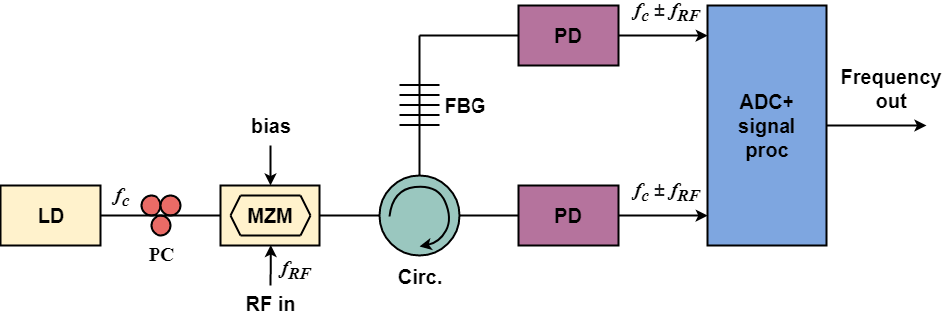
Figure 2. Schematic diagram of an IFM system based on a fiber Bragg grating for microwave frequency measurement. LD—Laser diode; MZM—Mach–Zehnder modulator; Circ.—Circulator; FBG—Fiber Bragg grating; PD—Photodiode (Adapted with permission from Ref [25]. Copyright 2010, Elsevier).